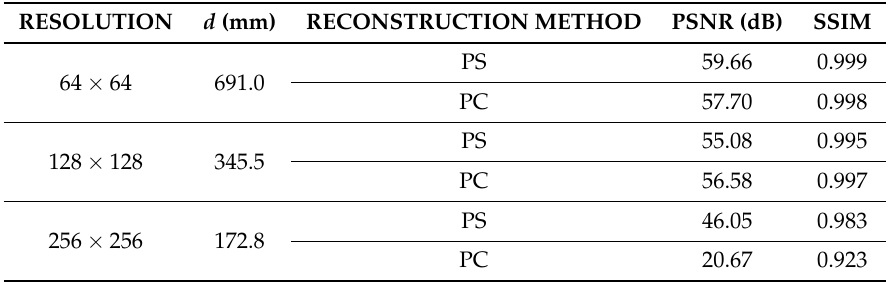
Figure 5. Reconstruction results of object plane with different resolution. Panels ( a , c , e ) are generated by PC and reconstructed by PS method; panels ( b , d , f ) are generated by PS and reconstructed by PC method. Table 1. Propagation distance d , peak signal-to-noise ratio (PSNR) and structural similarity index (SSIM) of PS and PC methods for object planes with different resolution.